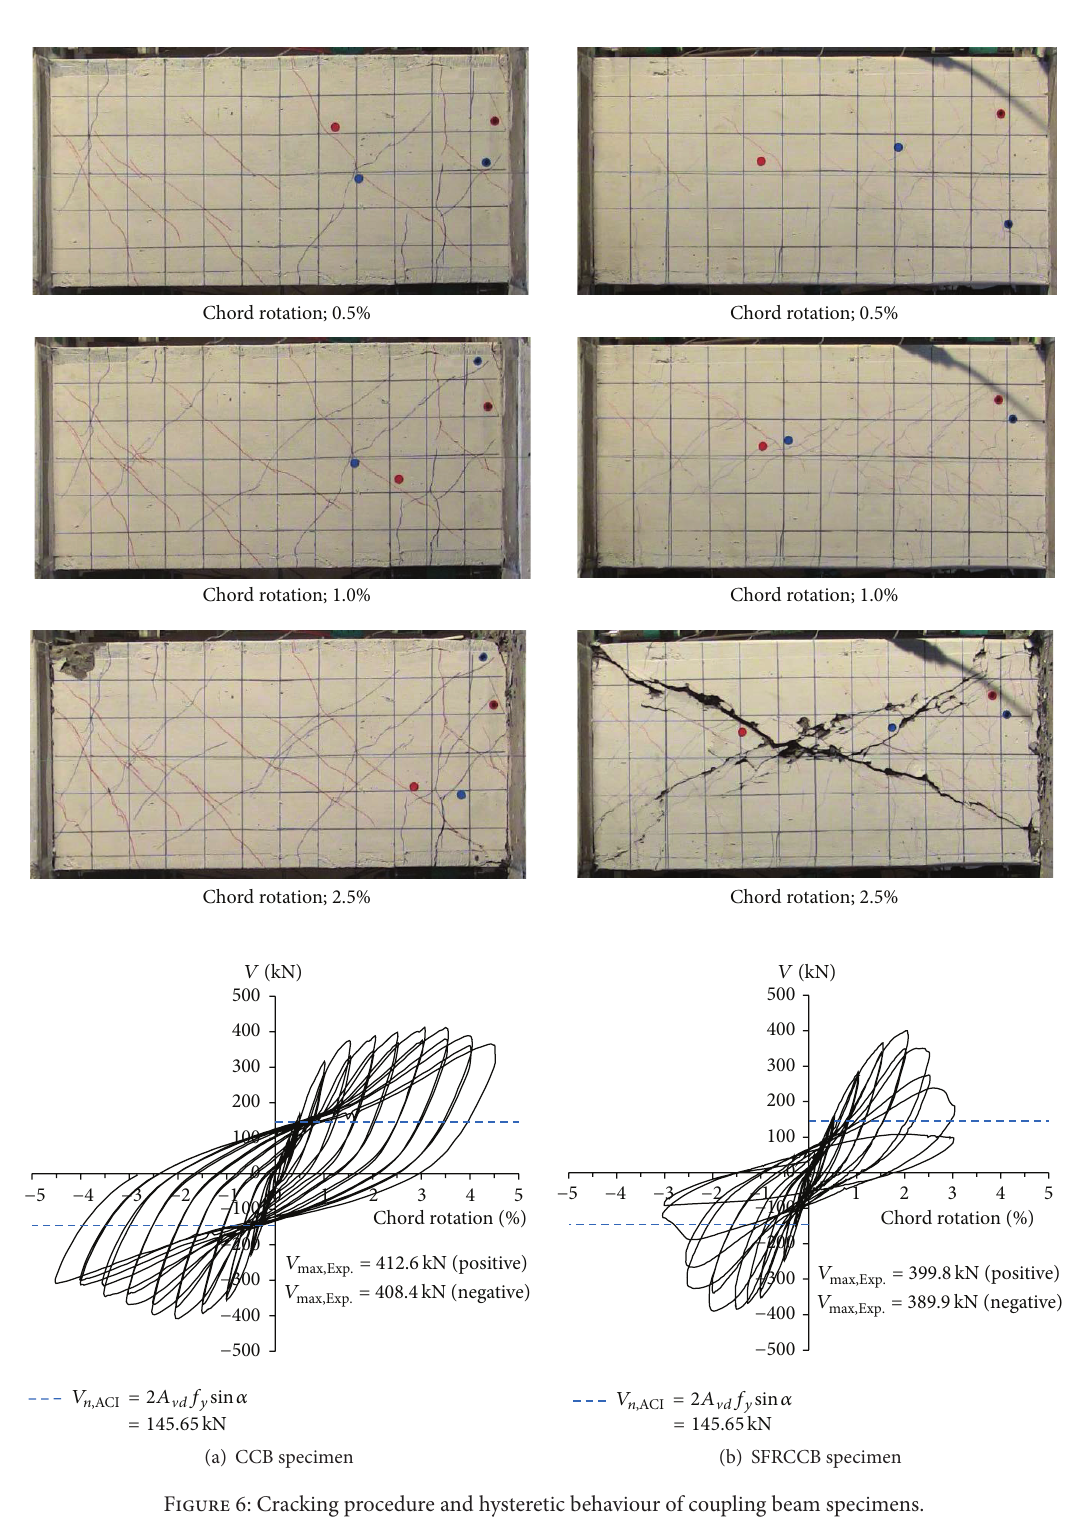
Figure 6: Cracking procedure and hysteretic behaviour of coupling beam